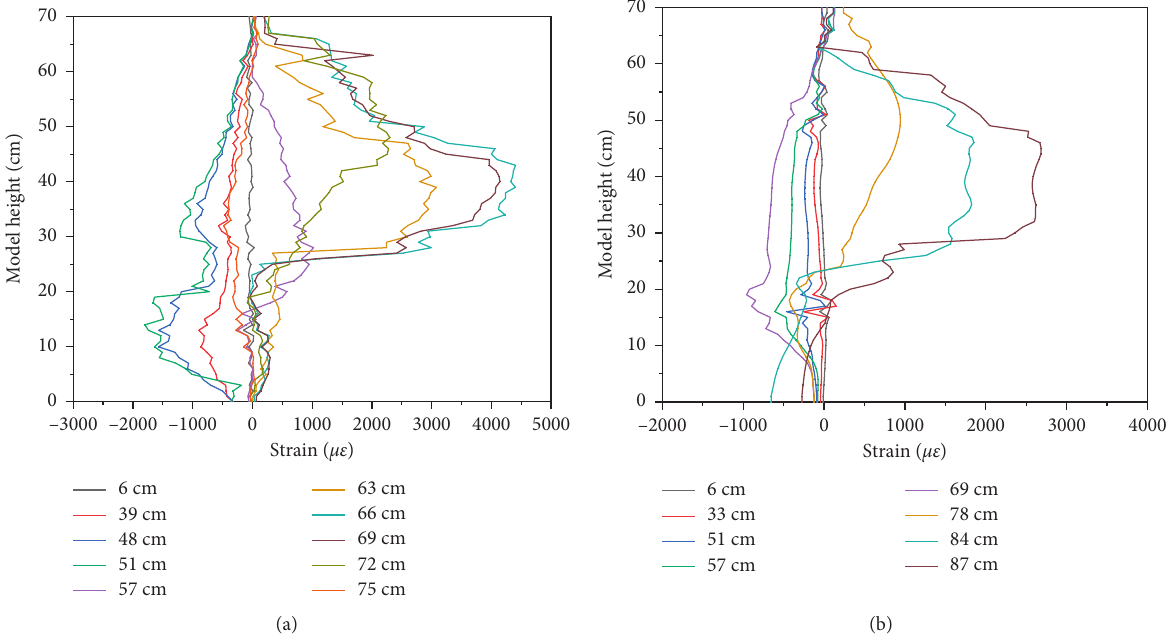
Figure 6: Results of fiber optic testing of overburden deformation at the working face. (a) Fiber V12 of physical model I. (b) Fiber V22 of physical model